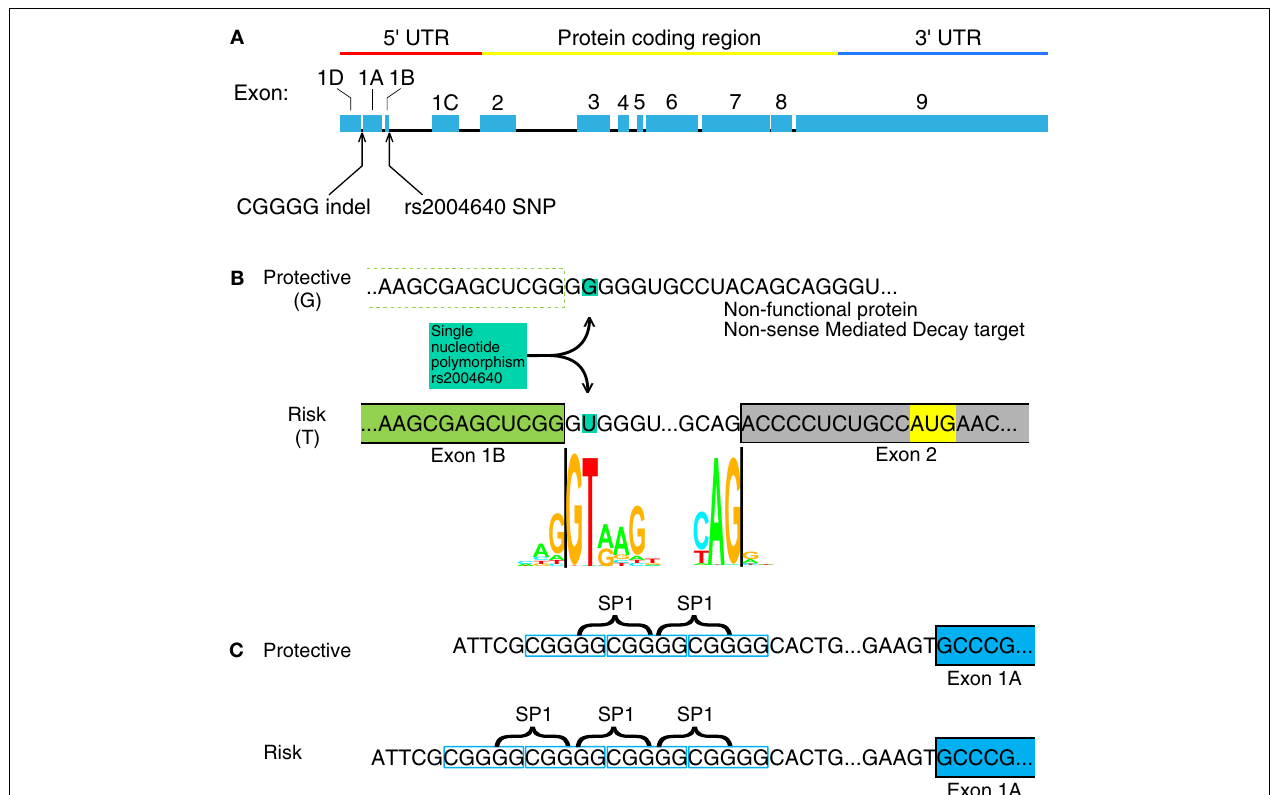
position, and thus the high GT represents a strong preference for recognizing GT at the intron boundary.This matches in the riskT allele (GT at the intron boundary), but not the protective allele (GG at the intron boundary). A person homozygous for the protective allele cannot splice IRF5 mRNA that begins with exon 1B. Instead of a functional protein, the resultant mRNA would encode a non-functional protein and be targeted for non-sense mediated decay. Splice junctionWebLogos are from Stephens and Schneider (7). ( C) The CGGGG indel is an insertion/deletion of a CGGGG repeat upstream of exon 1A, and it is part of exon 1A’s promoter.When there are four copies, additional SP1 transcription factors (which bind to GGCGG) can bind to the promoter, altering transcription levels. UTR, untranslated region; SNP, single nucleotide